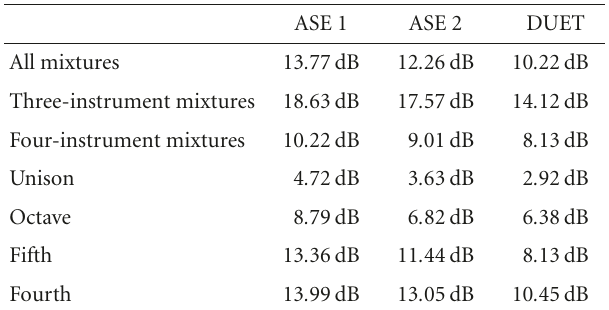
Table 1: Median signal-to-distortion ratio of the ASE and DUET algorithms on 1000 three-instrument mixtures (3000 signals) and 1000 four-instrument mixtures (4000 signals). The table also shows median performance on three- and four-instrument mixtures con- taining specific musical intervals: unison (2383 signals), octave (366 signals), perfect fifth (1395 signals), and perfect fourth (1812 sig- nals). Higher values are better.